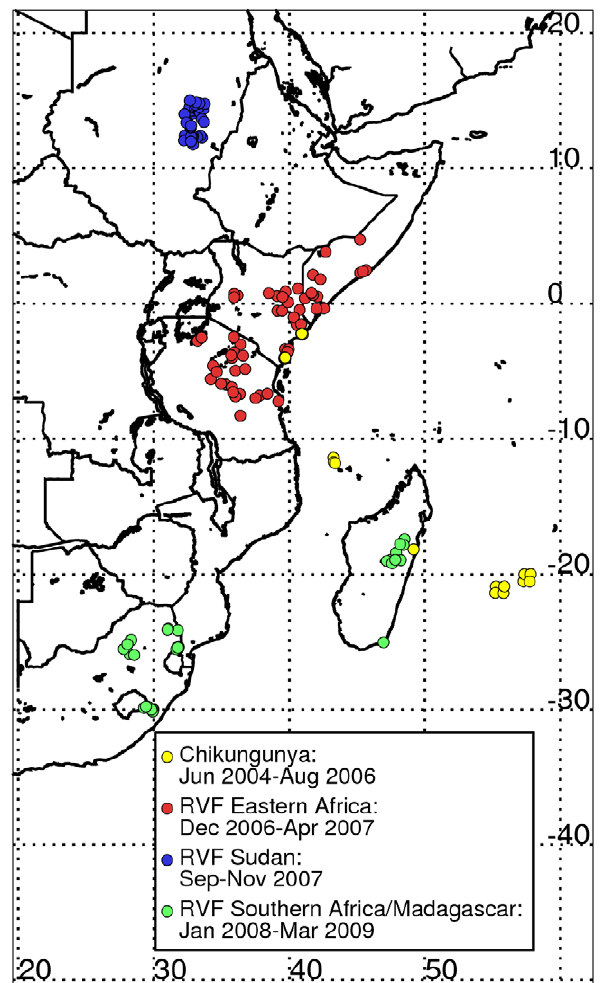
Figure 2. Outbreak locations of chikungunya (2004–2006) and Rift Valley fever (2006–2009). Symbols indicate distribution of recent outbreaks of chikungunya (2004–2006) shown by yellow dots and Rift Valley fever (2006–2009) shown by red, blue and green dots over eastern and southern Africa and the Indian Ocean islands.